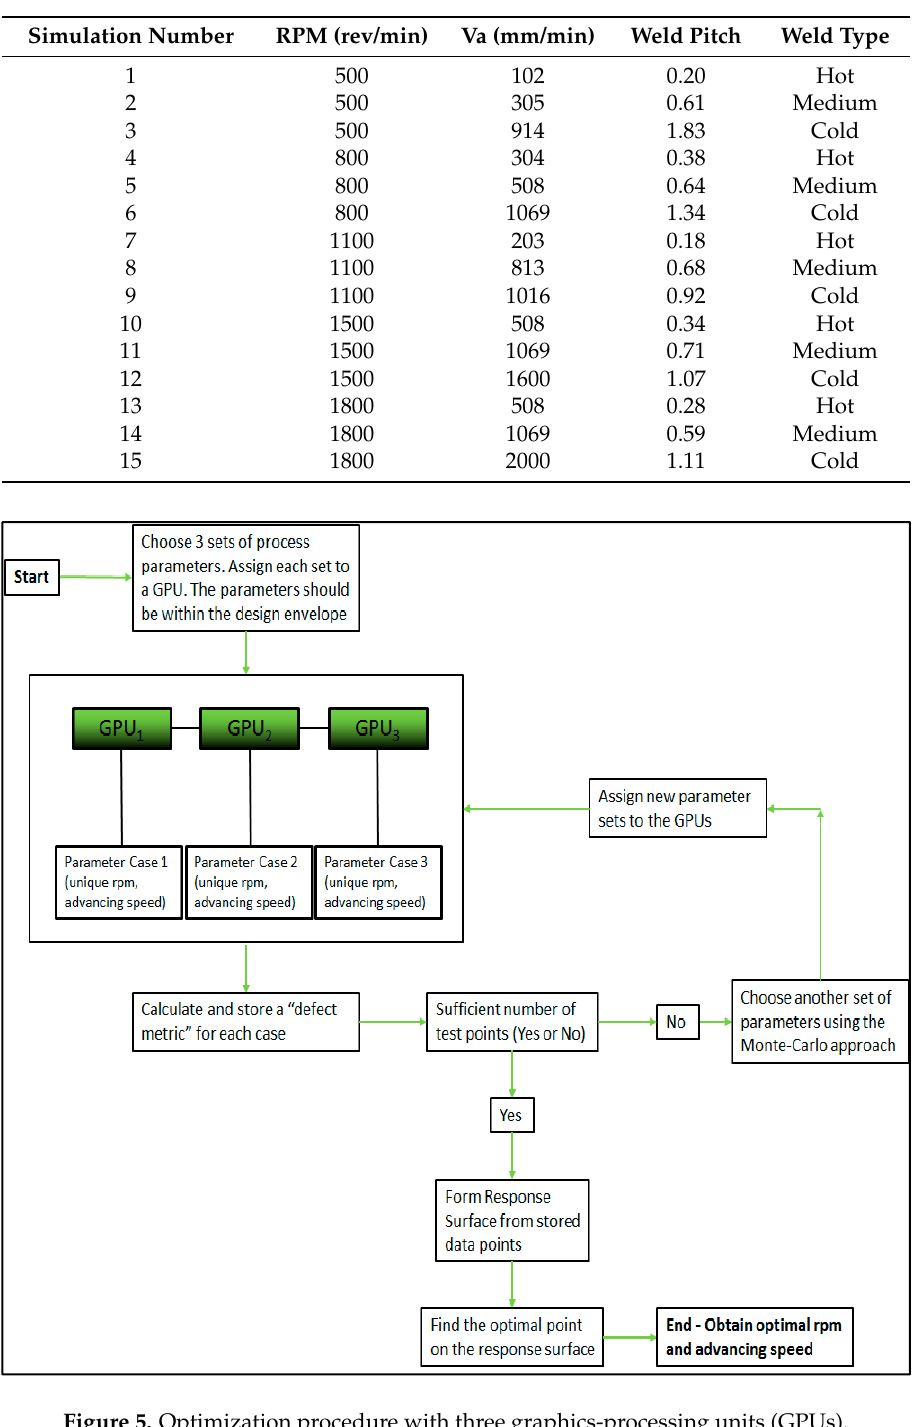
Table 4. Process parameter sets for optimization.